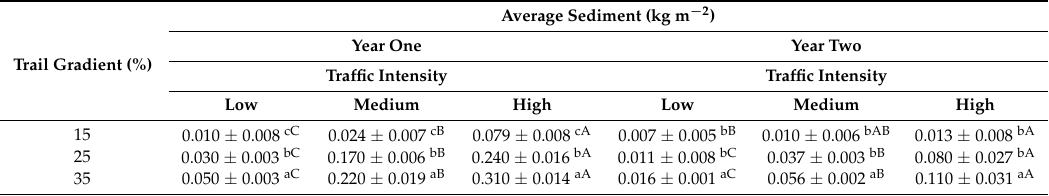
Table 4. Means ( ± std) of sediment (kg m − 2 ) on different trail gradients, traffic intensities, and years.